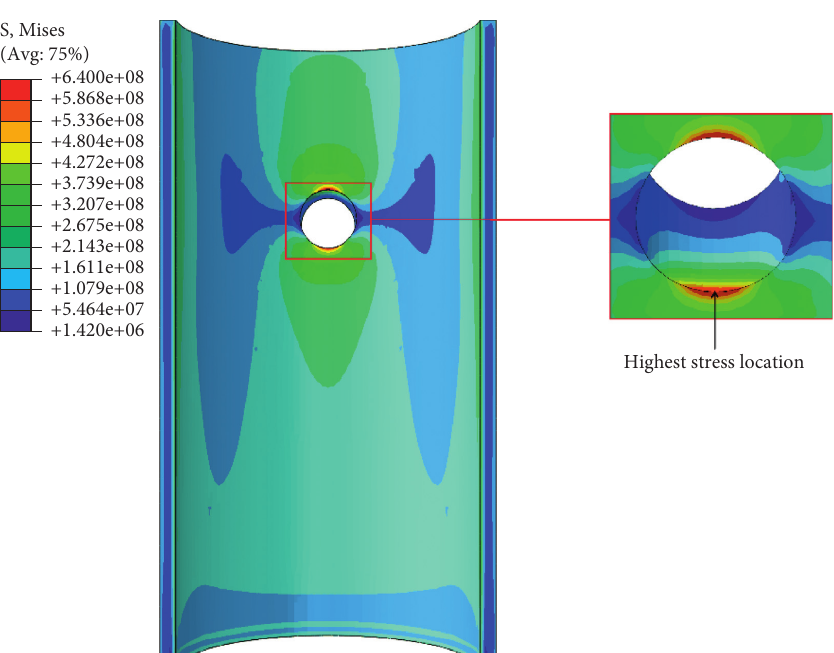
Figure 10: Maximal stress location at the inlet nozzle-inner vessel wall intersection of the RPV